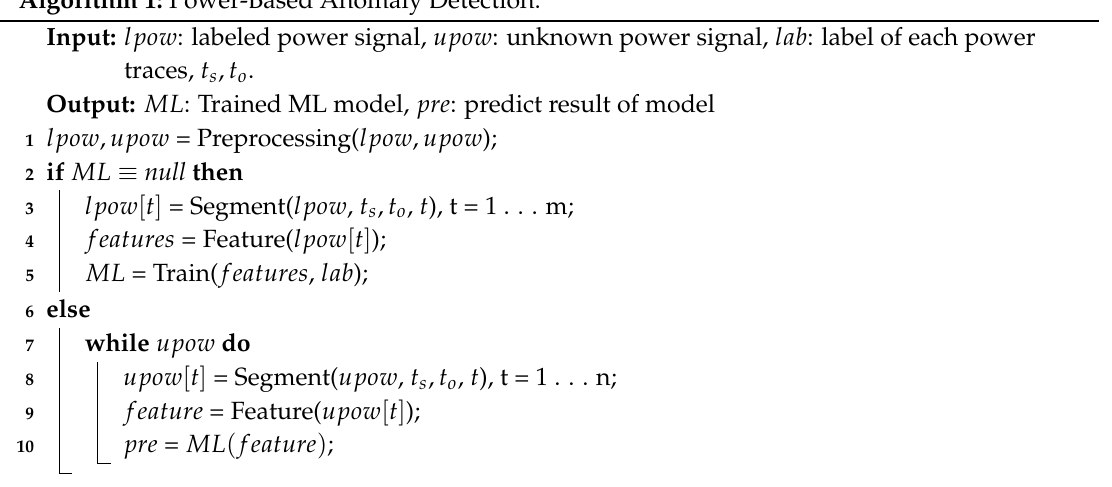
Algorithm 1: Power-Based Anomaly